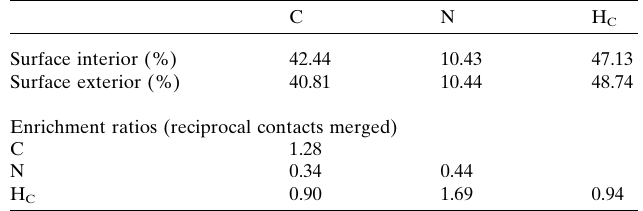
situation, the relevance of the C (36.26%), Cl (25.08%) and H (27.34%) atoms, while values in Table 6 show that the C C (cid:2) (cid:2) (cid:2) N contacts are significantly enriched (ER = 2.15). When